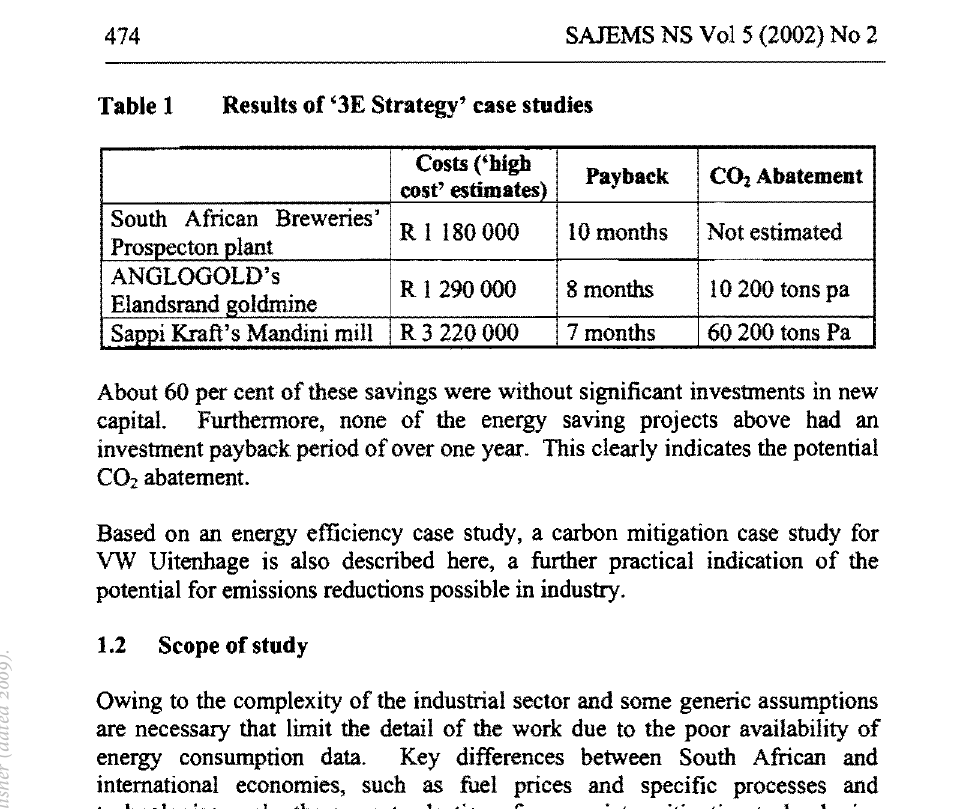
Results of '3E Strategy' case studies Costs ('high cost'